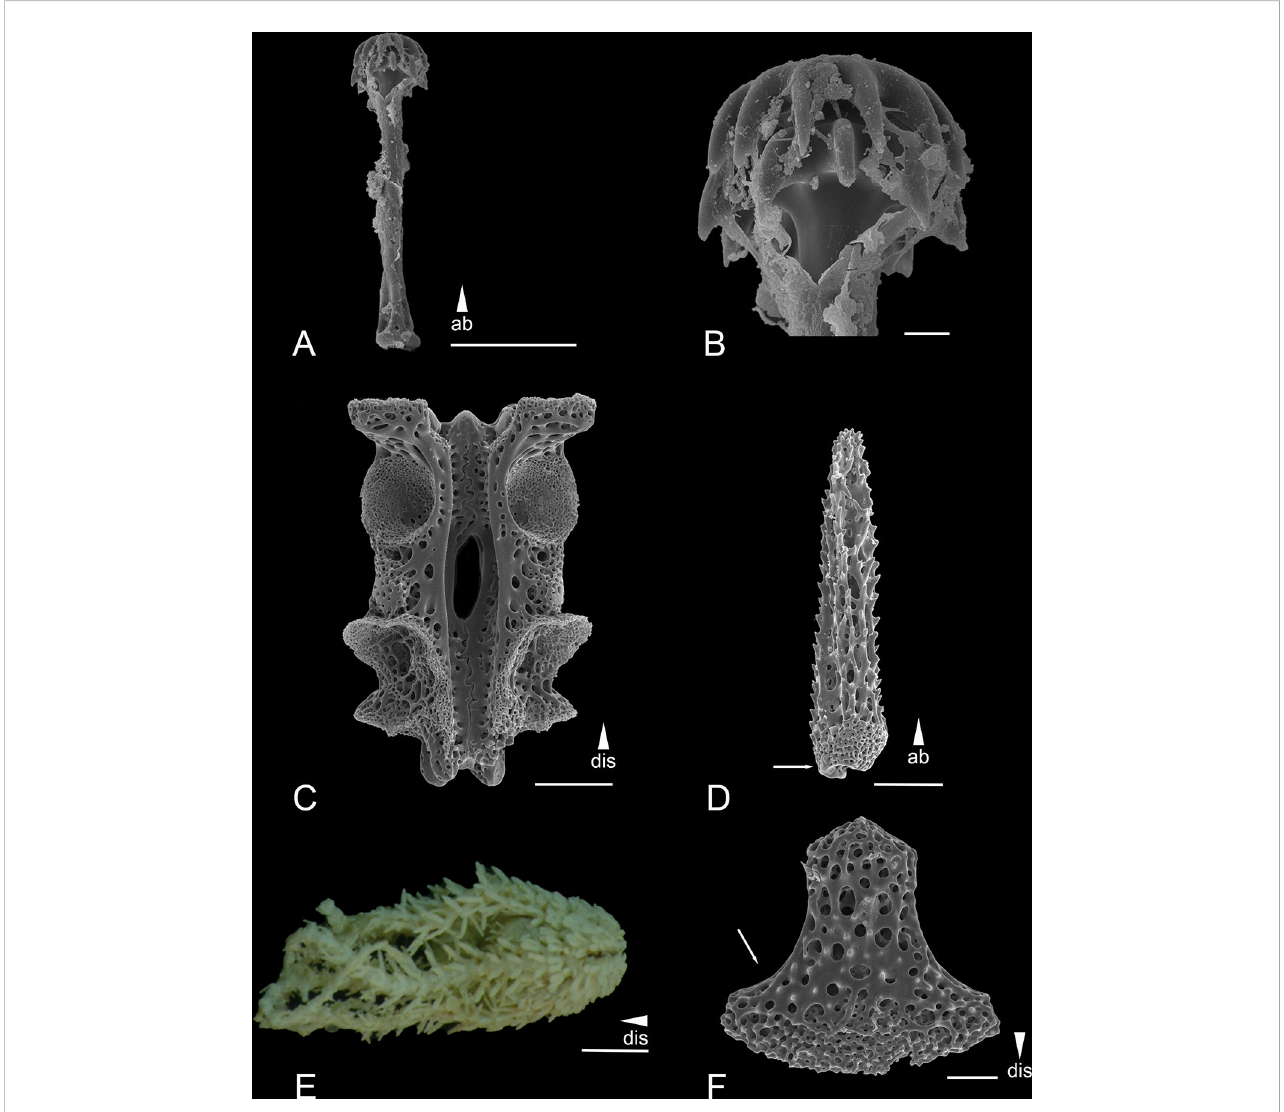
FIGURE 6 Scanning electron microscope images of the ossicles from Ophiotholia odissea (A) Parasol-spine; (B) Head of parasol-spine; (C) Arm vertebrae (ventral); (D) Arm spine; (E) Habitus; (F) Ventral arm plate. Scales: 10 µm (B) ; 50 µm (F) ; 100 µm (A, C, D) ; 1 mm (E) ab, abradial; dis,